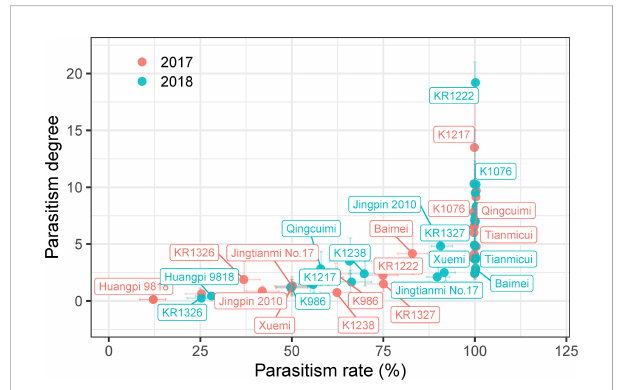
FIGURE 2 Parasitism degree and parasitism rate of the different melon cultivars in pot experiments. Vertical and horizontal bars indicate standard errors of parasitism degree and rate, respectively ( n = ~3 – 8, biological replicates). Only some representative melon cultivars are shown in the fi